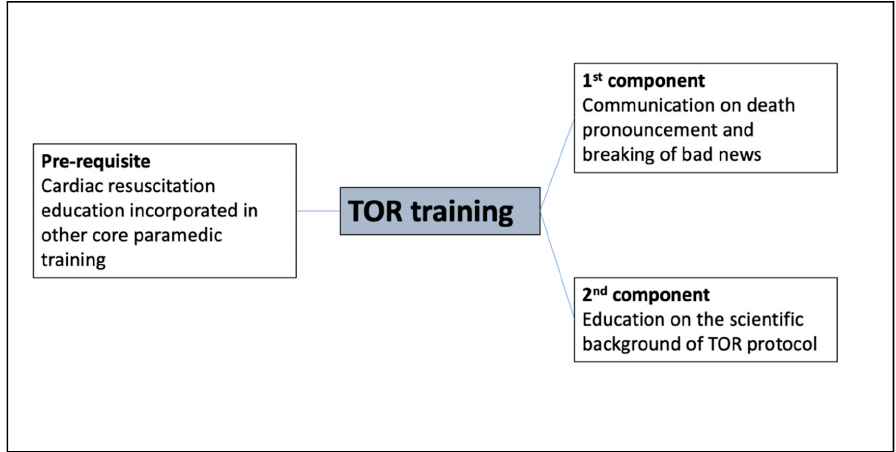
Figure 1. Pre-requisite and components of termination of resuscitation (TOR) training.